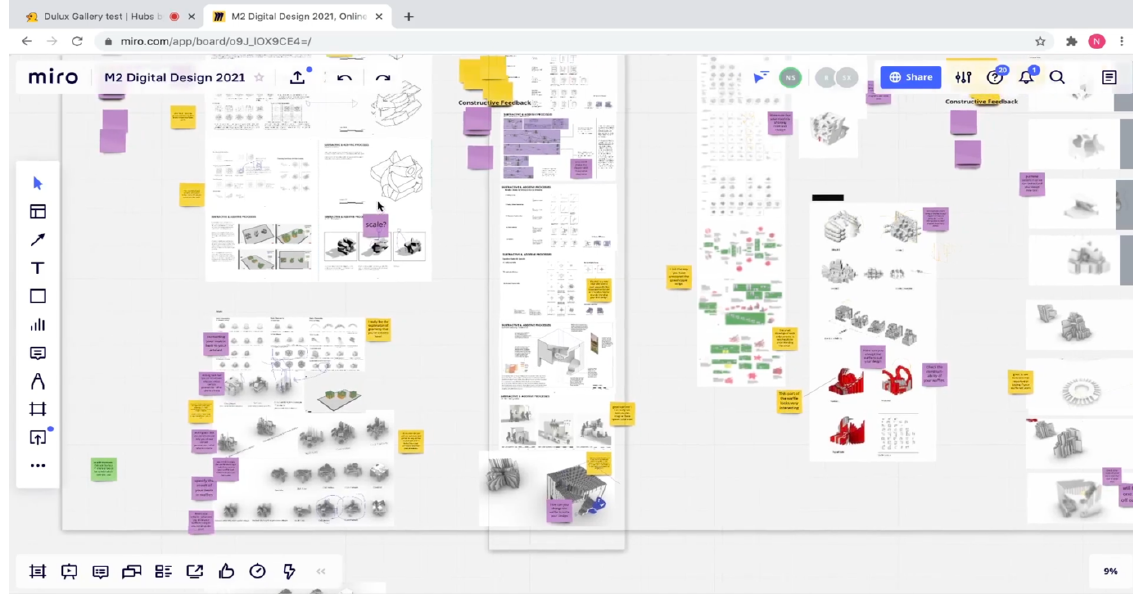
Figure 8. An online whiteboard for students to share progress and pin-up presentations (Miro) (Source: student work on the Miro platform as part of teaching by Nancy Samayoa, 2022; the students whose work is presented have agreed to this reproduction for